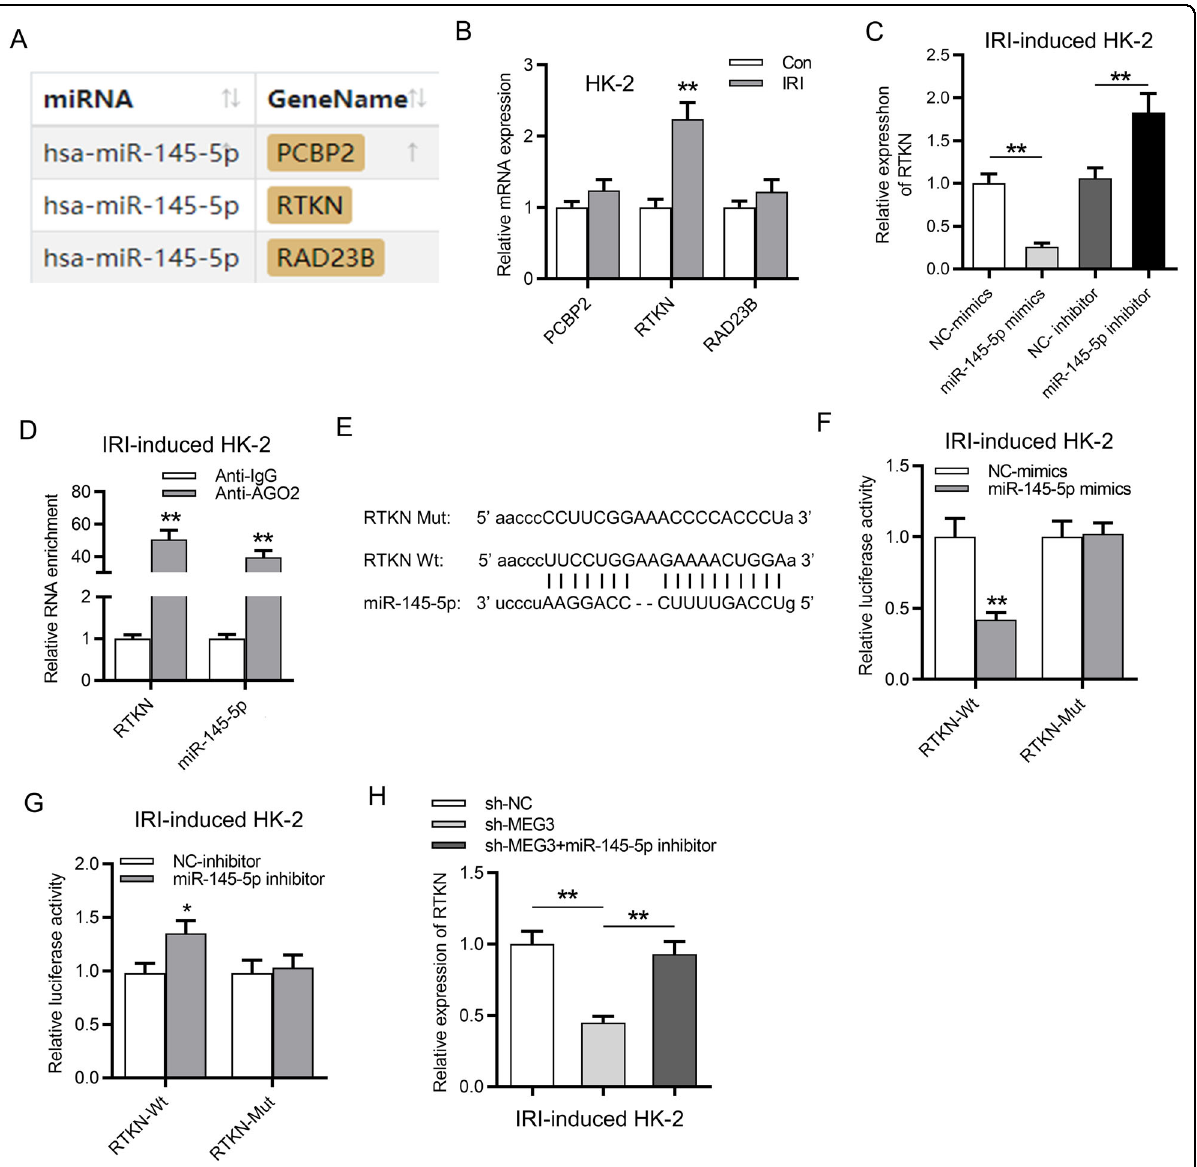
Fig. 5 RTKN served as a target of miR-145-5p. A Three potential targets (PCBP2, RTKN, and RAD23B) for miR-145-5p were revealed. B Relative RTKN expression was determined in IR-treated HK-2 cells. C The in fl uence of miR-145-5p mimics and miR-145-5p inhibitor on RTKN expression was determined by RT-qPCR. D RIP assay demonstrated relative enrichment of miR-145-5p and RTKN in the anti-IgG and anti-Ago2 groups. E The binding site of RTKN and miR-145-5p was predicted from starBase. F , G Luciferase activity revealed the in fl uence of miR-145-5p mimics and miR-145-5p inhibitor on luciferase activity of pmirGLO RTKN-Wt and pmirGLO RTKN-Mut plasmids. H RTKN expression was determined by RT-qPCR in HK-2 cells transfected with sh-NC, sh-MEG3, and sh-MEG3 + miR-145-5p inhibitor. * p < 0.05, ** p <